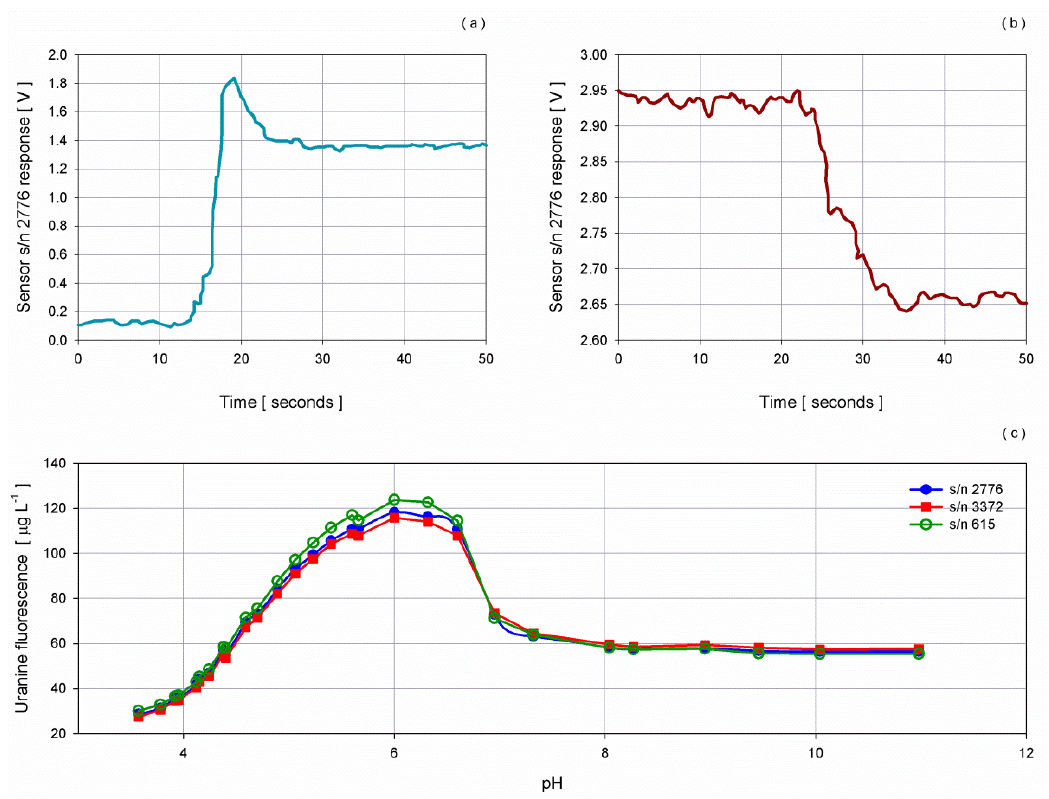
Figure 13. Voltage signal of sensor s/n 2776: ( a ) the steep increase when 30 mL of Uranine was poured into filtered sea water and; ( b ) the rapid drop when 1 mL of HCl 0.5 M was added into the chamber making pH decreasing from 4.7 down to 4.4.; ( c ) the chlorophyll- a curves as pH varies.